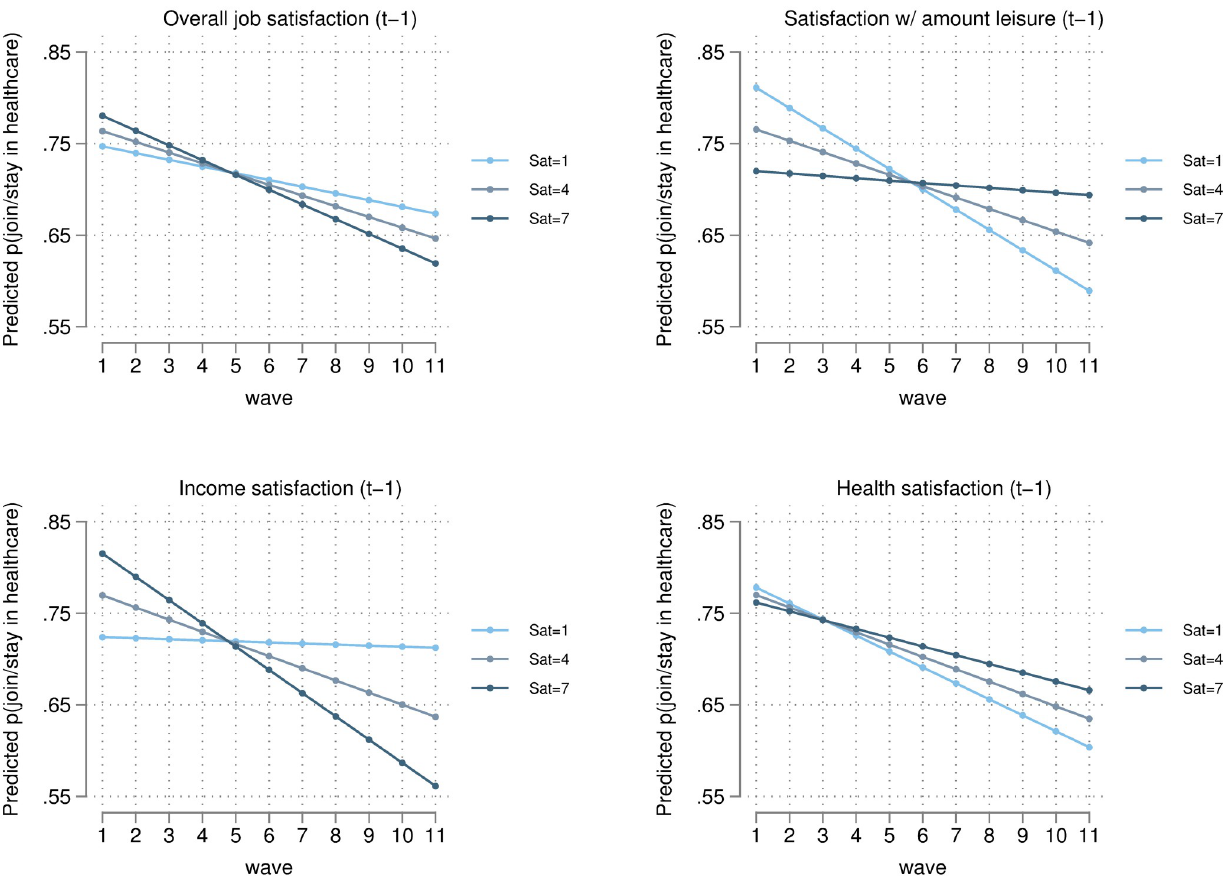
Fig 4. Predicted probability of joining/staying in the healthcare sector with different levels of lagged satisfaction, measured on 1–7 scale (estimated from FE regression 1 in Table 2).